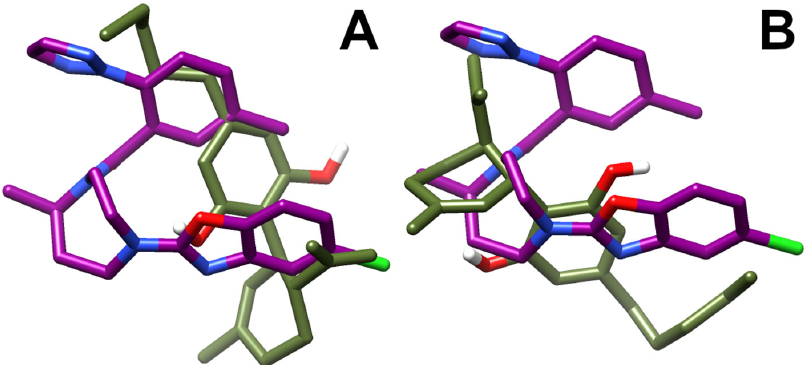
Figure 8. Best-fit superposition of protein backbones between CBD poses I ( A )/III ( B ) and the x-ray structure of the OX1R-suvorexant complex. Only the ligands are shown for clarity and drawn in stick representation. The suvorexant is colored in deep purple and the CBD in olive drab. Hydrogen, nitrogen, oxygen, and fluorine atoms are painted white, blue, red and green, respectively.